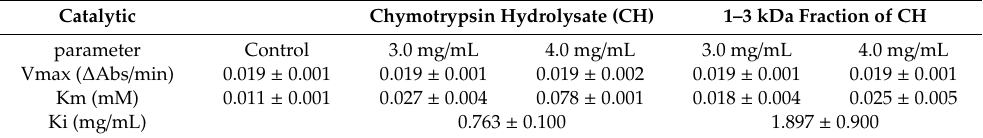
Figure 5. Lineweaver–Burk plots of chymotrypsin inhibition at di ff erent peptide concentrations: ( A ) chymotrypsin hydrolysate ( R 2 = 0.88, 0.96, and 0.85 for 0, 3, and 4 mg / mL, respectively) and ( B ) chymotrypsin hydrolysate 1–3 kDa peptide fraction ( R 2 = 0.88, 0.84, and 0.84 for 0, 3, and 4 mg / mL, respectively). Table 3. Kinetics constants for chymotrypsin inhibition by protein hydrolysate and peptide